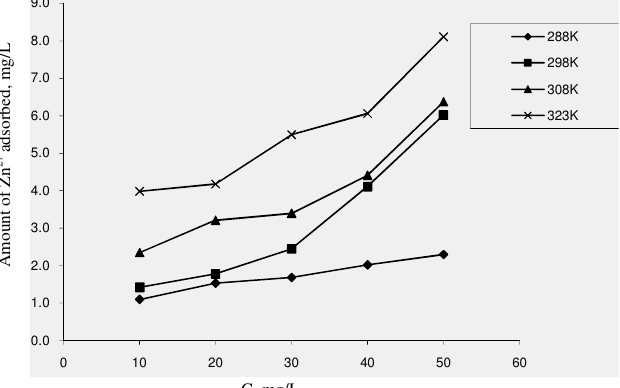
Figure 1. Variation of amount of Zn 2+ adsorbed by human hair with concentration of Zn + in solution at various